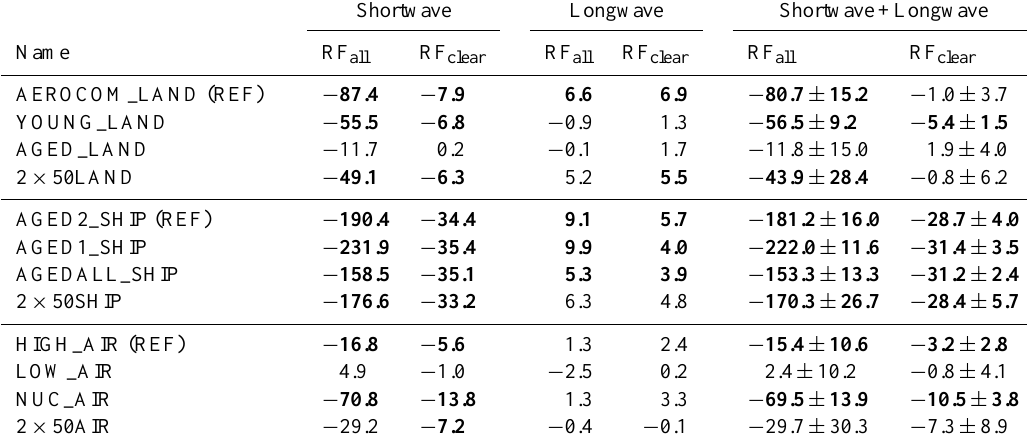
Table C1. Multi-year average (1996–2005) all-sky and clear-sky radiative forcings (in units of mWm − 2 ) of transport-induced aerosol perturbations calculated for the different model experiments. The results are shown for the shortwave, longwave and combined (short- wave+longwave) bands. Significant values according to a uni-variate t test (5% error probability) are marked in bold. The 95% confidence intervals are provided for the combined band. Note that due to rounding, the values for the combined bands may deviate from the sum of the corresponding shortwave and longwave values. The values for the combined band correspond to the radiative forcings presented in Fig. 12.